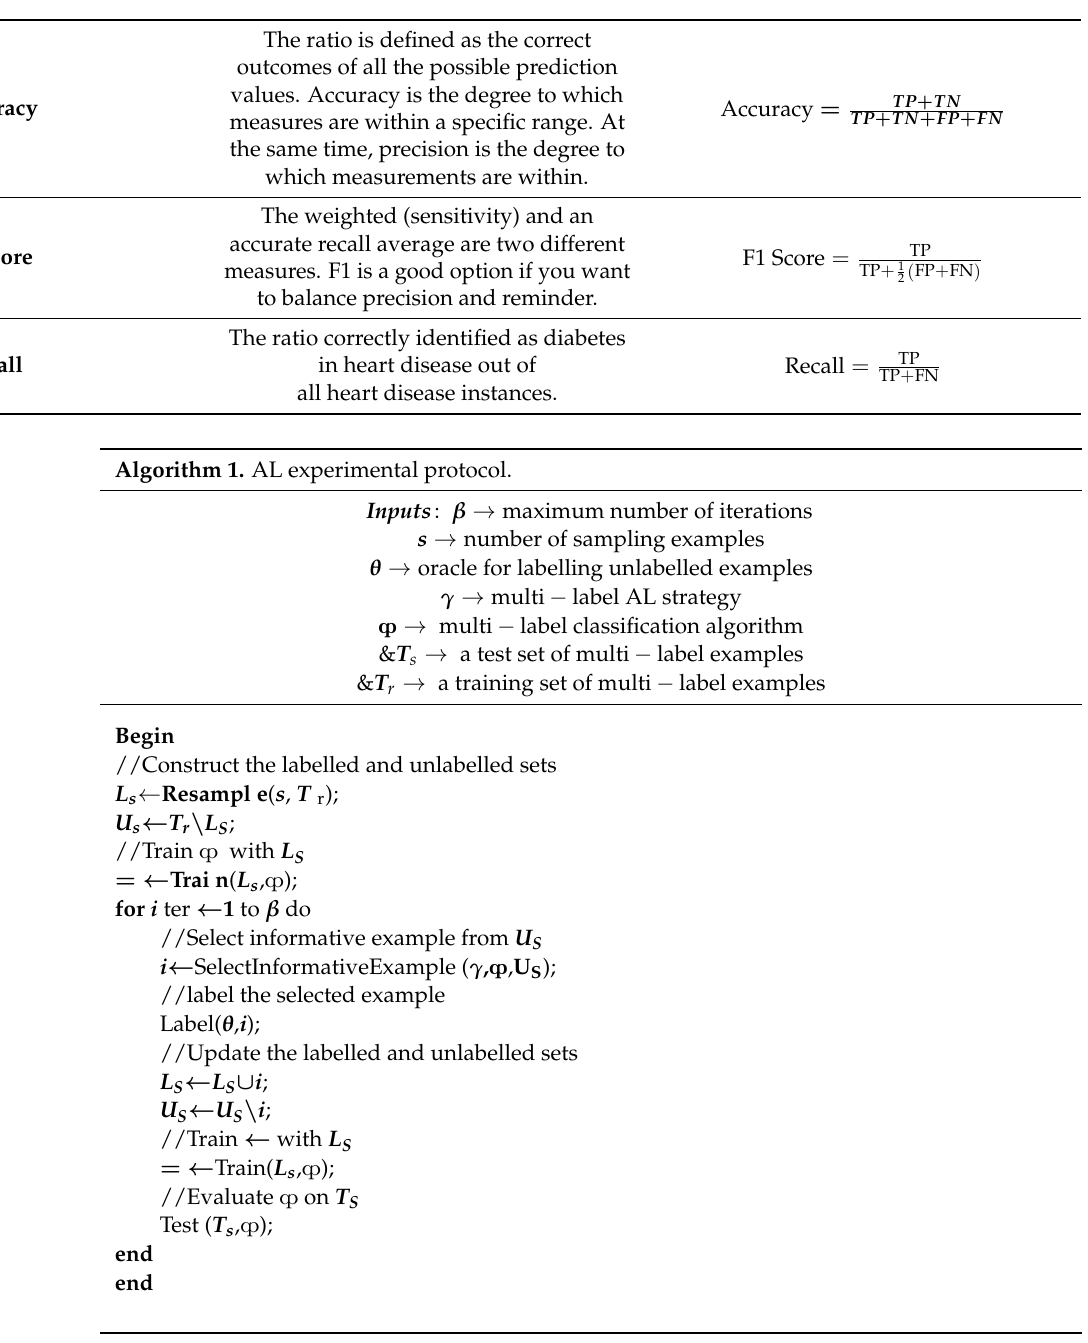
Table 3. Performance evaluation metrics.